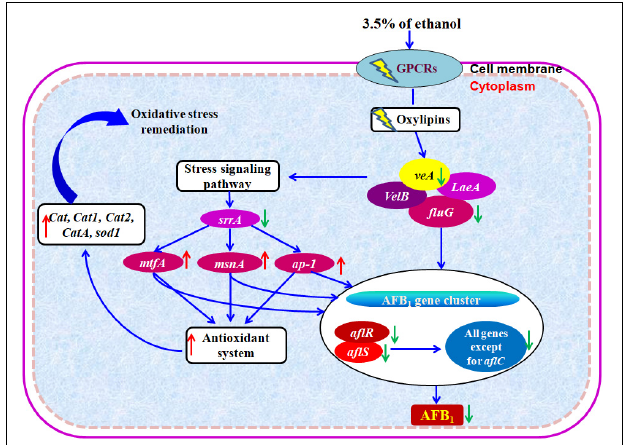
FIGURE 6 | Hypothetical mechanism of action of ethanol on AFB 1 biosynthesis. Down- and up-regulation of gene on ethanol addition is expressed using green and red arrows,